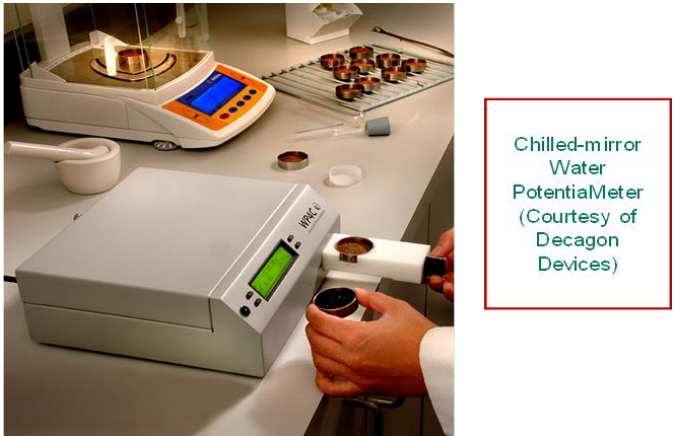
Figure 9. Chilled-mirror PotentiaMeter (Courtesy of Decagon Devices; now Meter Inc.).